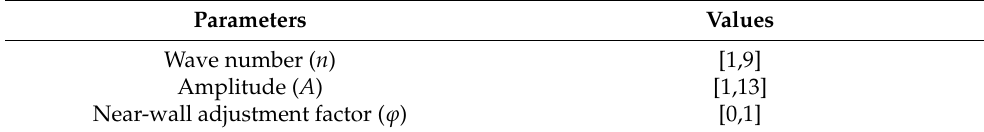
Table 1. Ranges of variables.